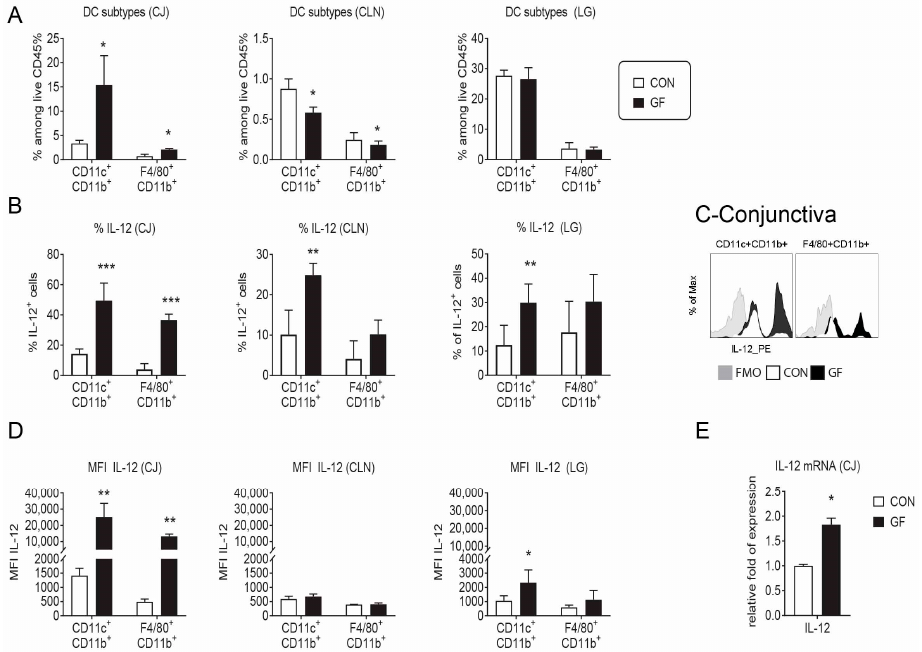
Figure 2. DC frequency and production of IL-12 is altered in germ-free mice. Single cell suspensions of the conjunctiva (CJ), cervical lymph nodes (CLN) and lacrimal glands (LG) were prepared and stained for antigen-presenting cell and macrophage markers followed by intracellular staining for IL- 12. Bar graphs are shown as means ± SEM of a representative experiment with 4–5 samples per group. The experiment was repeated once with similar results. ( A ) Accumulative data showing frequency of CD11b + CD11c + and F4/80 + CD11b + cells among alive CD45 + gated cells; ( B ) Accumulative data showing frequency of IL-12 + among viable CD45 + gated cells; ( C ) Representative overlaid histogram of IL-12 staining in conjunctival CD11b + CD11c + and F4/80 + CD11b + cells; ( D ) Accumulative data showing median fluorescence intensity (MIF) of IL-12 in positive cells; ( E ) Relative fold expression changes of IL-12 in full-thickness conjunctival biopsies. Bar graphs show means ± SD of five samples per group, biological replicates from two independent experiments were averaged. FMO = fluorescence minus one; GF = germ-free; CON = conventional mice; * p < 0.05; ** p < 0.01; *** p < 0.001. Mann–Whitney U test was used for GF vs. CON comparison test.